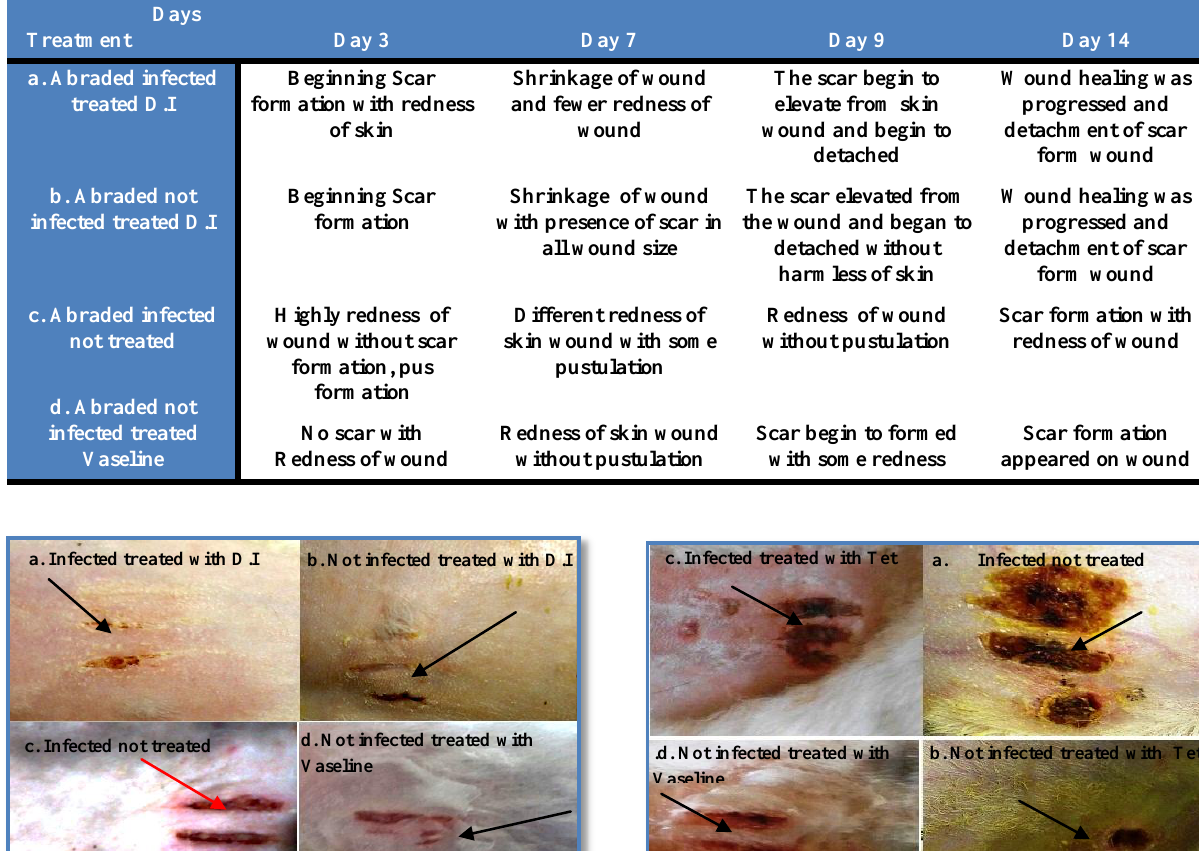
Table, 3: Healing sings after treat. with D.I extract on different period Days Treatment